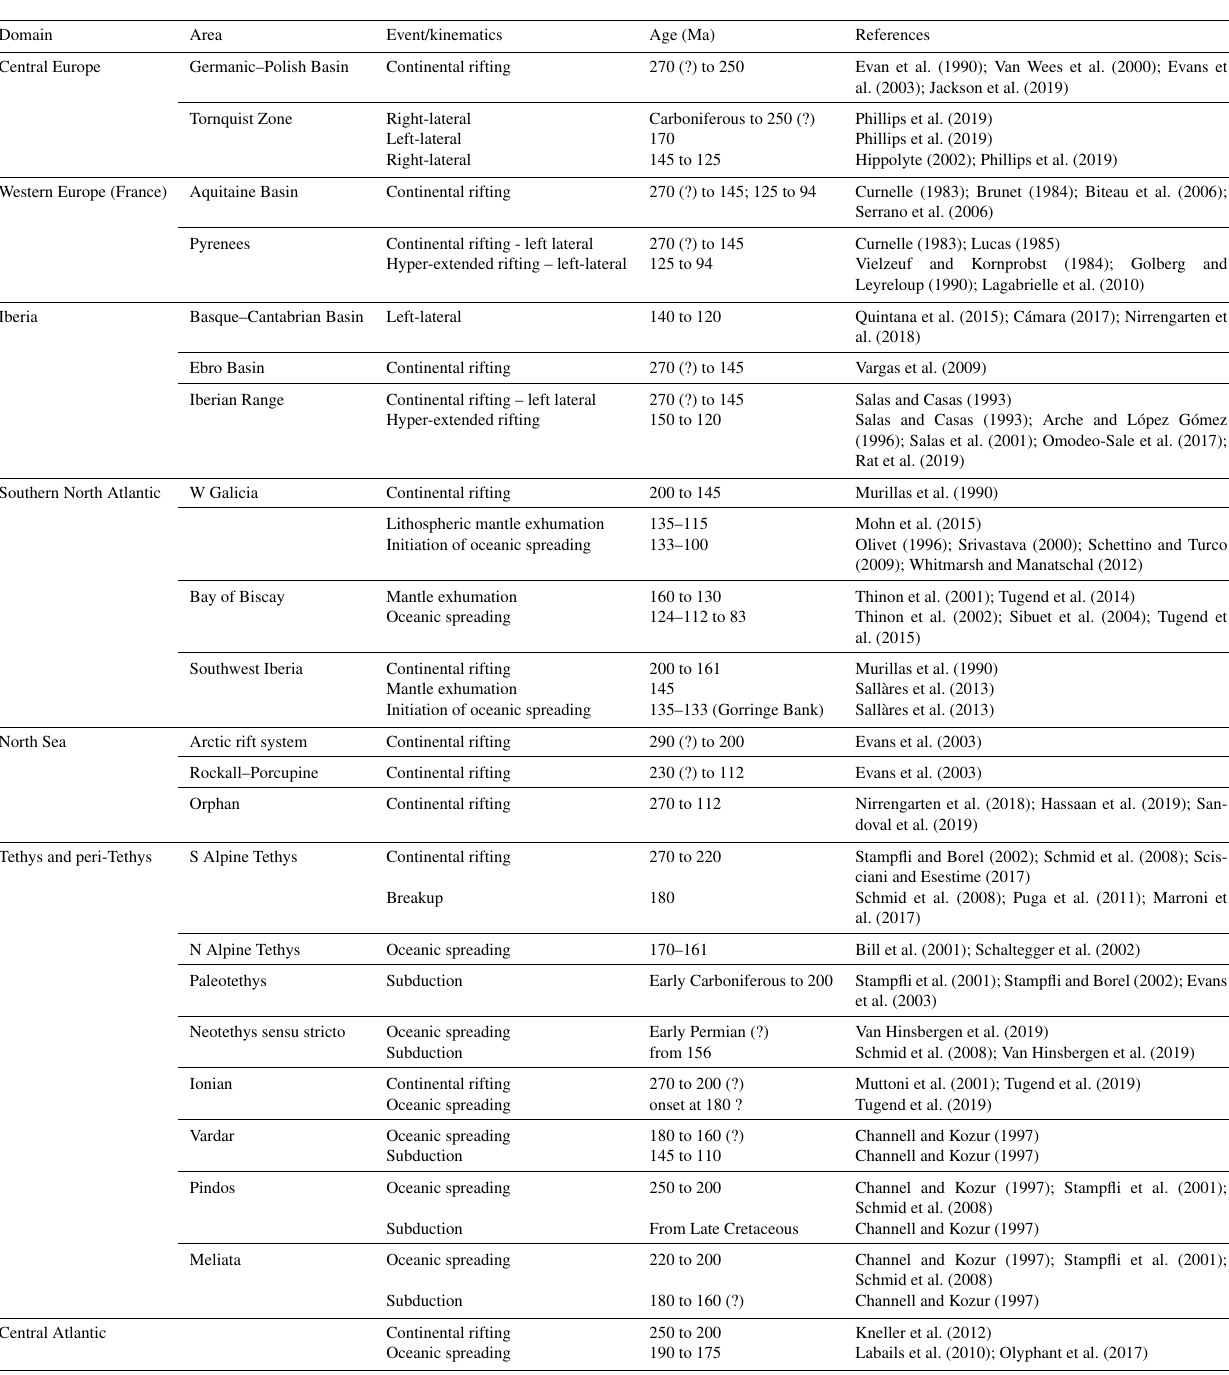
Table 2. Geodynamic and timing constraints used in the kinematic reconstruction